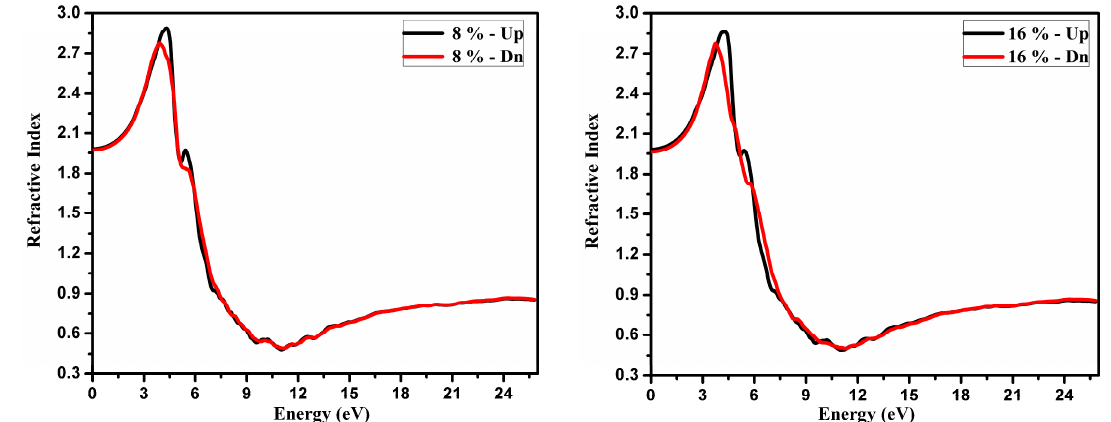
Figure 8. Calculated refractive index (long solid curve ‐ black color for up) and (long solid curve ‐ red color for down) spectra of Mn x Zn 1 − x Te (x = 8% and 16%) crystals.